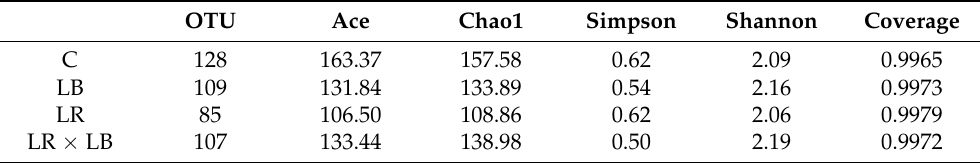
Table 4. Alpha diversity of paper mulberry